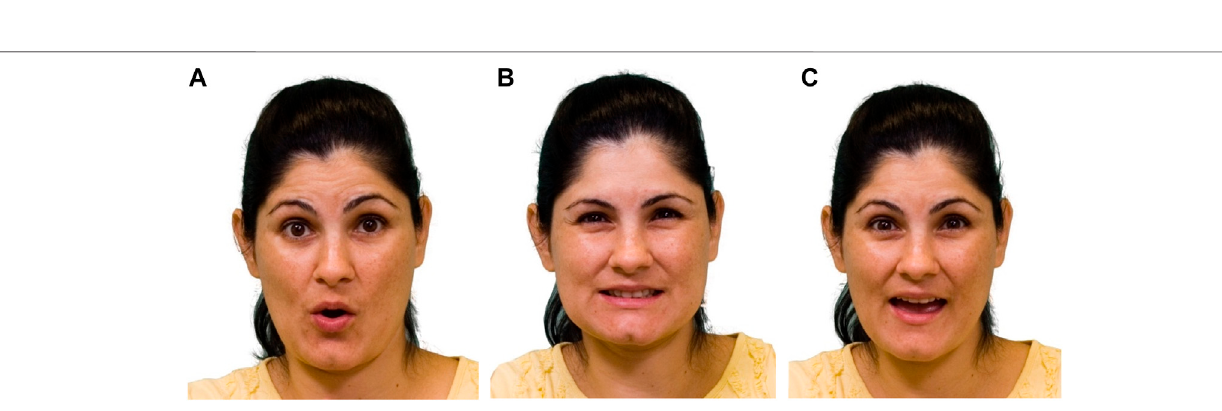
FIGURE5| Compositionallinguisticfacial intonationinISL: (A) browraiseonapolarquestion; (B) squint onshared information; (C) browraiseand squinttogether in a polar question about shared